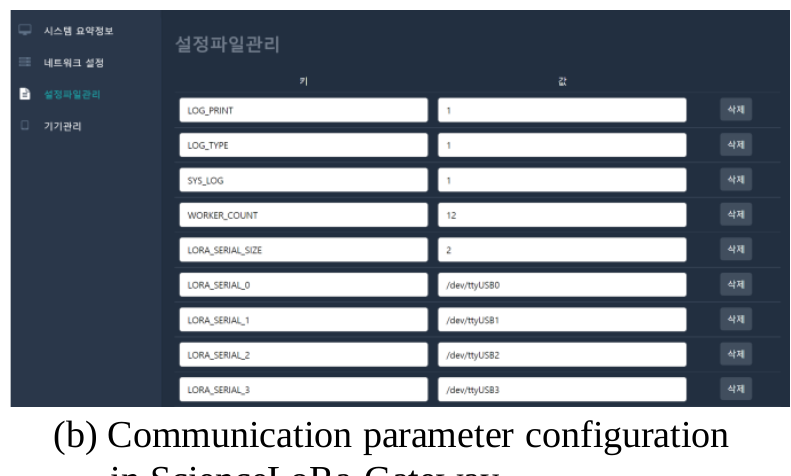
Figure 8. Web-based management system of